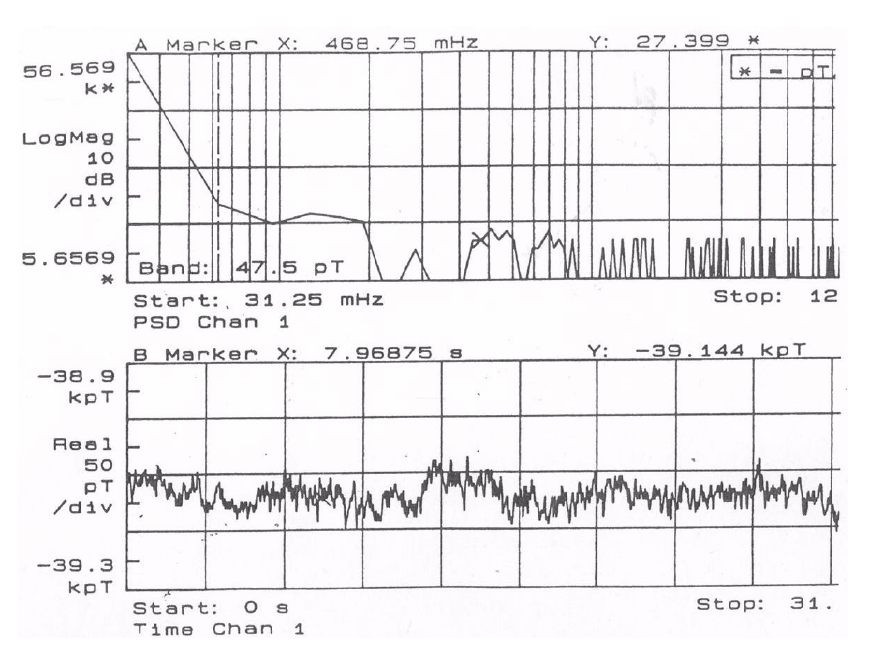
Figure 9. Noise level for selected CoFeSiB fluxgate